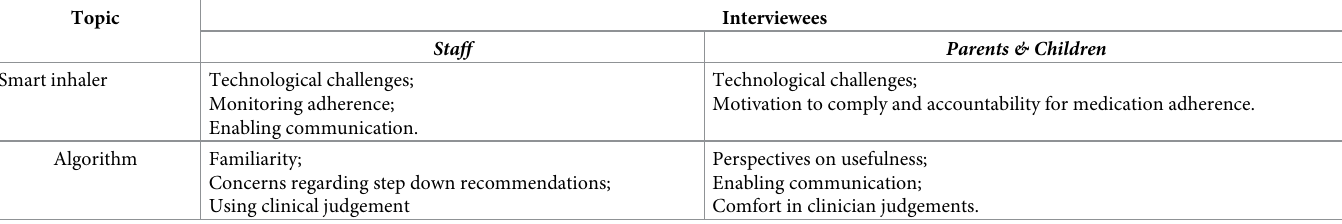
Table 2. Key themes arising from perspectives of trial staff and families regarding the smart inhaler and algorithm.